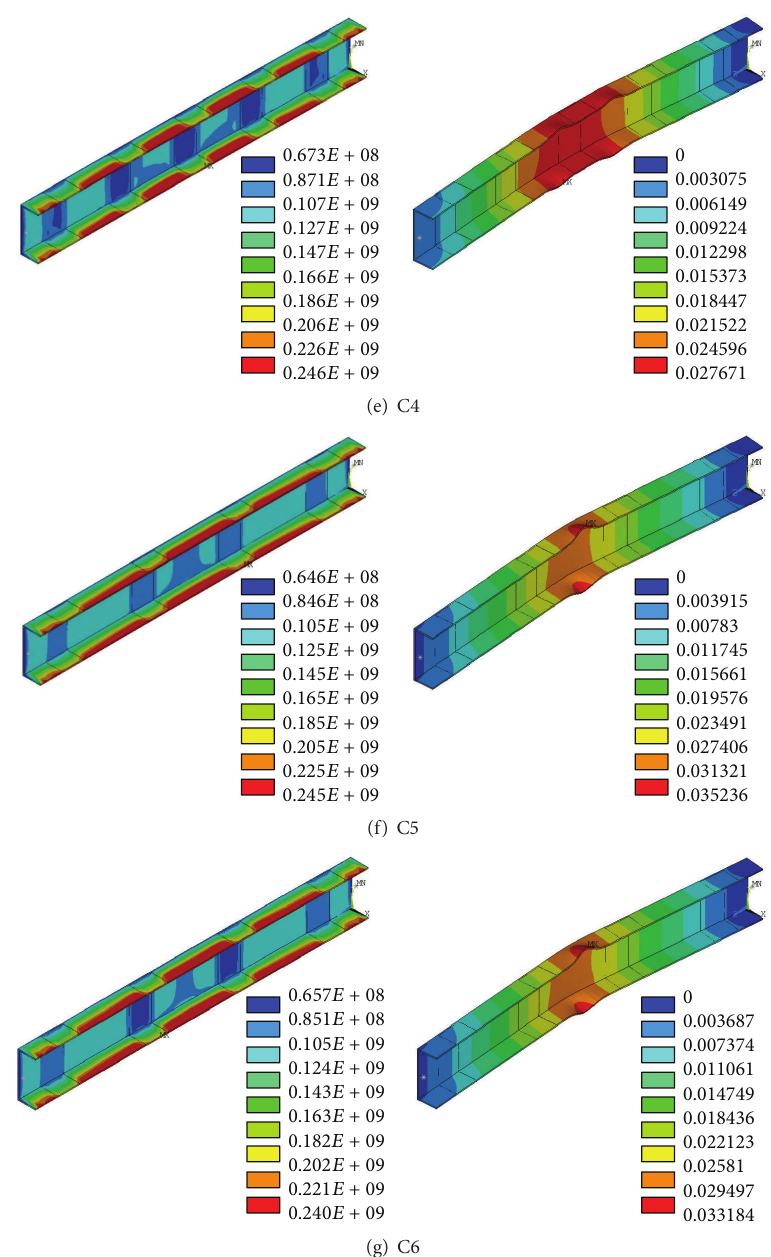
Figure 10: The Von-Mises graph and failure mode of